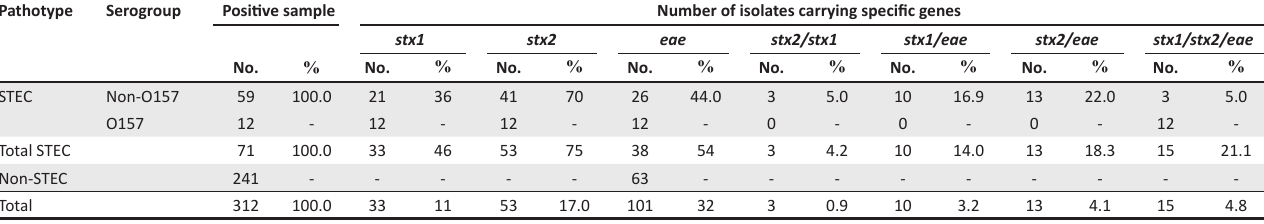
TABLE 2: Distribution of virulence genes in Shiga toxin-producing Escherichia coli strains. Pathotype Serogroup Positive sample